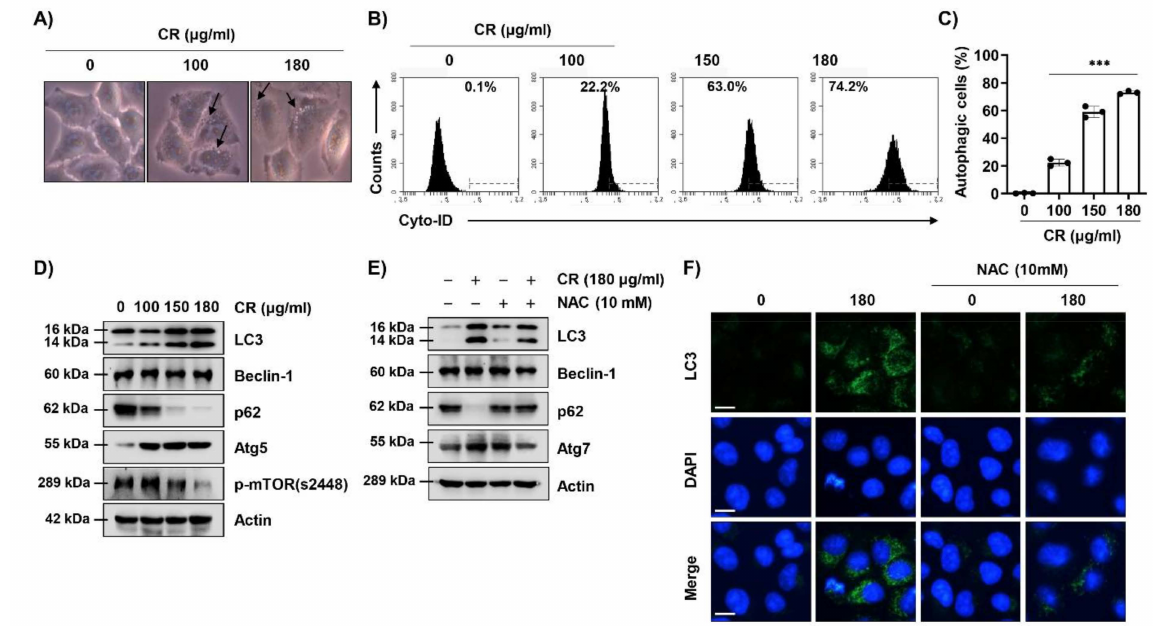
Figure 3. CR induces autophagy in Hep3B cells. ( A – D ) Cells were treated with the indicated concentrations of CR for 24 h. ( A ) Autophagic vacuoles were observed using a phase-contrast microscope at 400 × magnification. Arrows present autophagic vacuoles. ( B , C ) After treated with CR for 24 h, cells were collected and incubated with Cyto-ID staining solution for 30 min, and autophagic cells were measured and quantitated by a flow cytometer ( n = 3). *** p < 0.001 when compared to control. ( E , F ) Cells were pre-treated with or without 10 mM of NAC for 1 h, and then cells were treated with 180 µ g/mL of CR for 24 h. ( D , E ) Cells were harvested and lysed. The equal amounts of proteins were analyzed using Western blot analysis. The expression of microtubule-associated protein 1 light chain 3 (LC3)-I/II, p62, autophagy related (Atg) 5, Atg7, Beclin-1, and phosphorylated mechanistic target of rapamycin (p-mTOR) was observed. Actin was used as a loading control. ( F ) The LC3 puncta (green) was detected by immunofluorescence and photographed using a fluorescence microscope. DAPI was used to counterstained the nuclei (blue). Scale bars; 15 µ